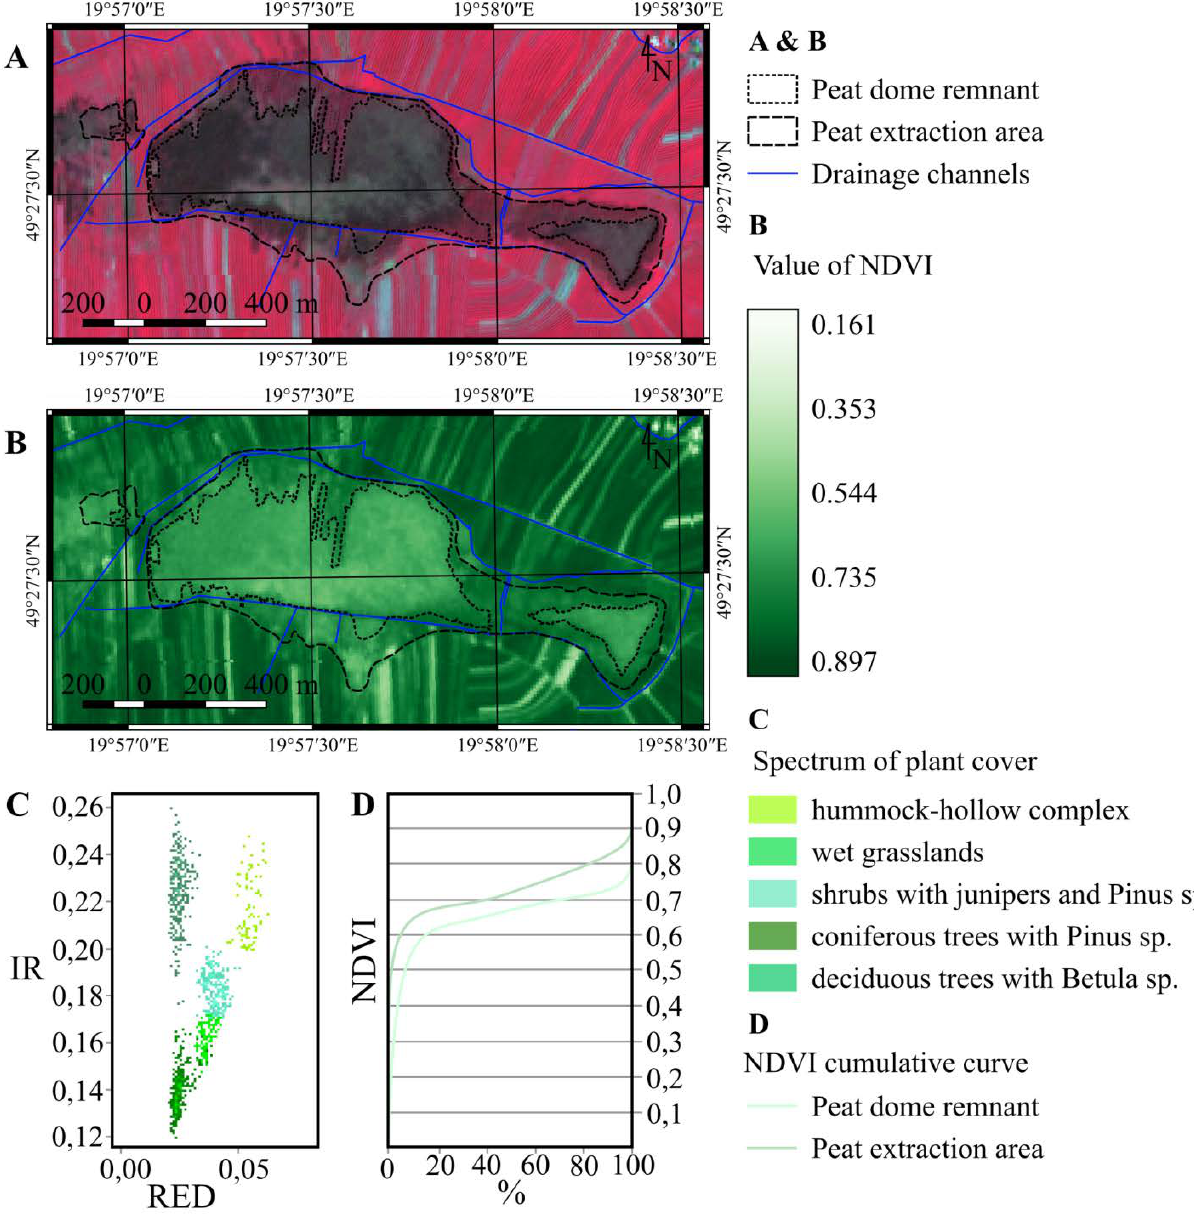
Figure 6. Vegetation characteristics on the dome from satellite data. A: Colour Infrared (CIR) satellite image of the study area; B: map of NDVI values; C: spectrum diagram of the vegetation types mapped in Figure 5B (bands RED and IR); D: cumulative curves of NDVI for the peat domes and peat extraction